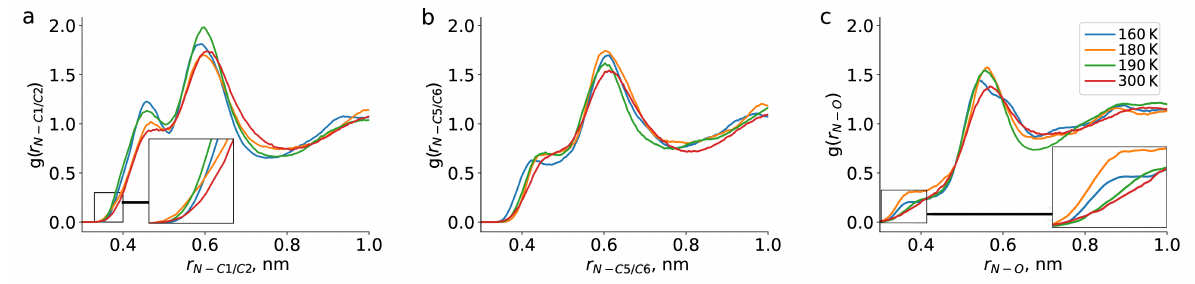
Figure 2. Radial distribution functions between carbon atoms of chain ends (C1 and C2) ( a ), rings (C5 and C6) ( b ), oxygen atoms (O) ( c ) of DBP and nitrogen atom of TEMPO (N) at different